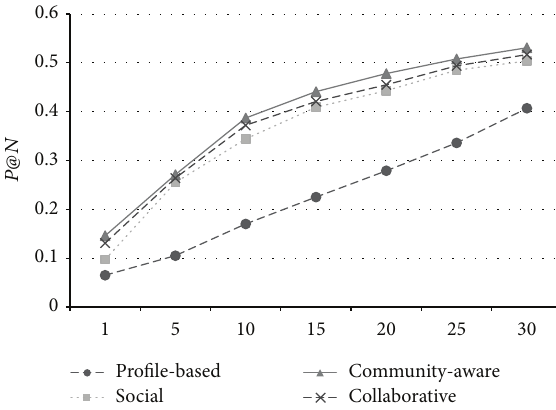
Figure 1: The performance of P@N on FMRS data set.